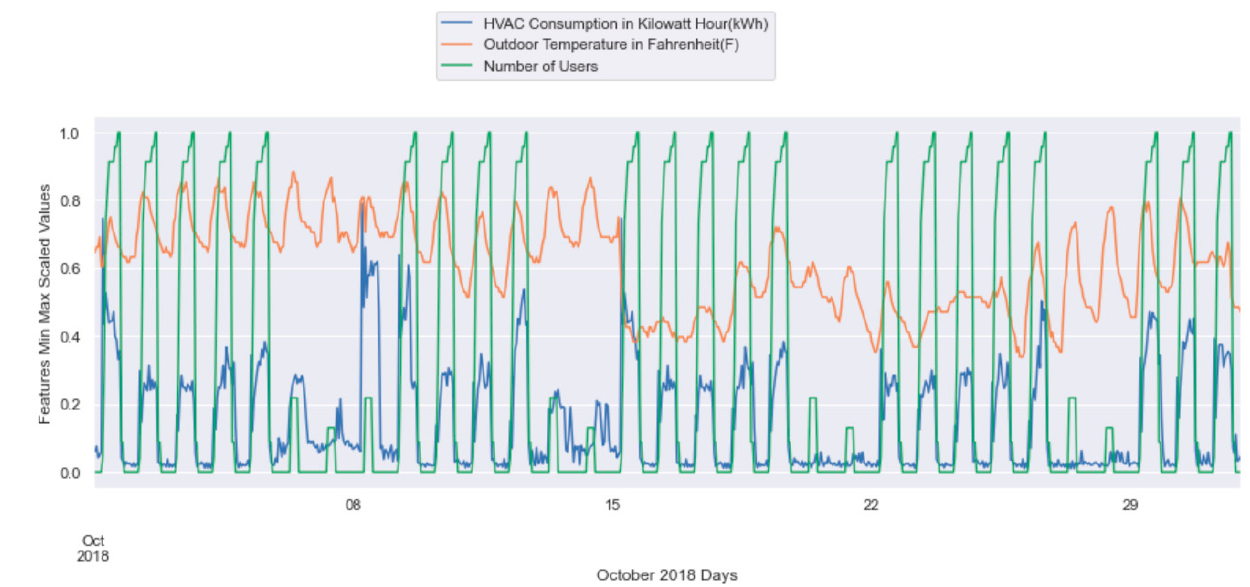
Figure 5. October 2018 data representation .